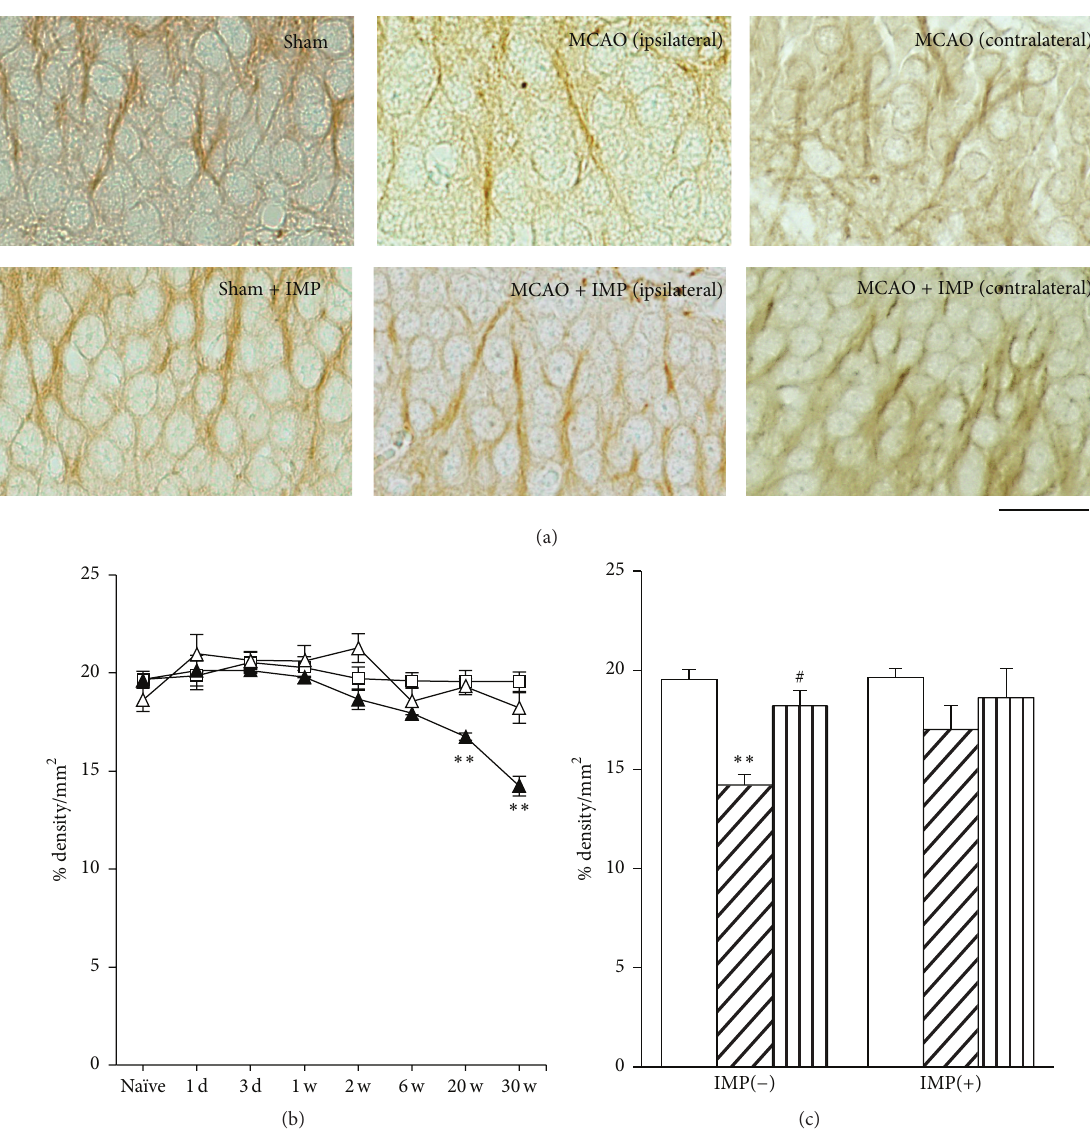
Figure 6: Analysis of MAP2 immunopositive areas in GCL. (a) Typical images of the slices taken at 30 weeks after MCAO. Scale bar indicates 20 𝜇 m. (b) Time course changes of MAP2 immunopositive areas after MCAO in GCL. Symbols used are as follows: open square, sham; closed triangle, ipsilateral MCAO; open triangle, contralateral MCAO. Statistical significance was evaluated with two-way ANOVA followed = 11.0 ; 𝐹 = 16.1 ; 𝐹 = 3.65 ; ∗∗ 𝑃 < 0.01 versus sham). (c) Analysis of the by Tukey-Kramer test at each time point ( 𝐹 ( ( group )2 ( time ∗ group )14,96 time )7 effect of IMP on MAP2 immunopositive areas at 30 weeks after MCAO. Vehicle [IMP( − )] or 20 mg/kg/day of IMP for 29 weeks [IMP(+)]